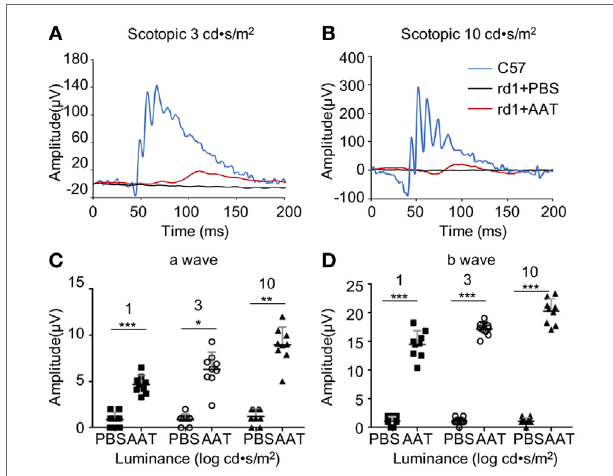
FigUre 4 | Alpha-1 antitrypsin (AAT) supplement protected retinal function in rd1 mice. (a,B) Retinal function was measured at P16 by electroretinogram using single-flash recordings at light intensities of 3.0 and 10.0 log cd•s/m 2 , respectively. C57 mice presented with typical a- and b-wave responses ( n = 6), while the PBS-treated rd1 mice showed nearly undetectable amplitude of a- or b-waves under a variety of scotopic testing conditions. (c,D) AAT treatment induced mild increase in a-wave but significant elevation of b-wave amplitudes in the rd1 mice. n = 9 mice for each group. * p < 0.05, ** p < 0.01, *** p < 0.001 (two-tailed unpaired t